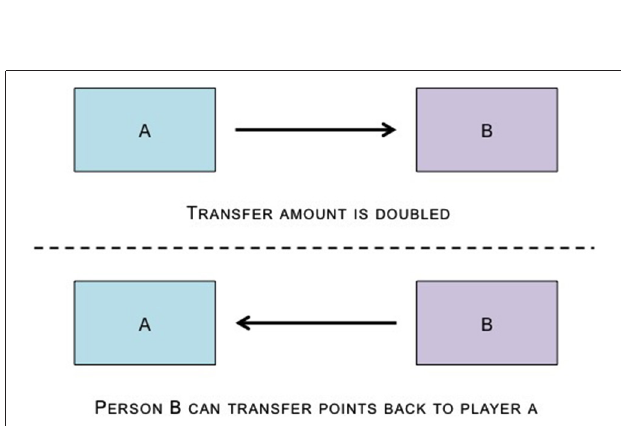
FIGURE 4 | The Trust Game has two participants, an investor (Person A) and a trustee (Person B). Person A is given some money and told that they must send a proportion (from zero to the full amount) of this money to Person B, and that the experimenter will multiply the money by some amount. Once Person B receives the money, they are told that they must send back a portion of it to Player A, again ranging from zero to the full